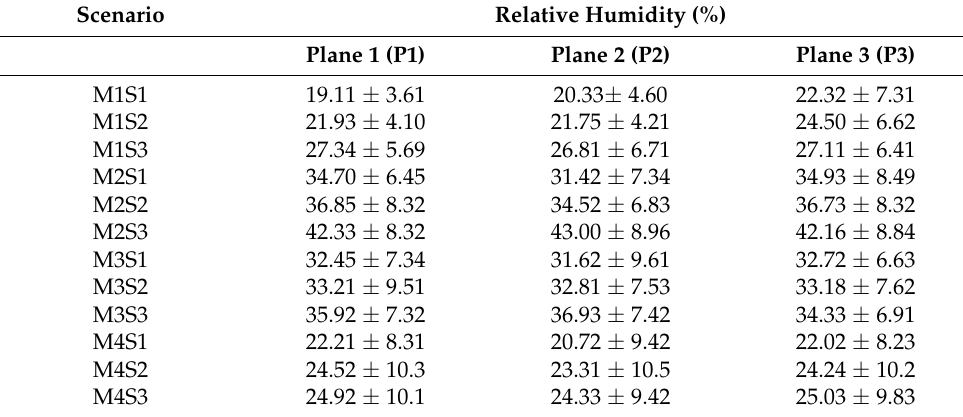
Table 7. Average relative humidity values obtained for each simulated